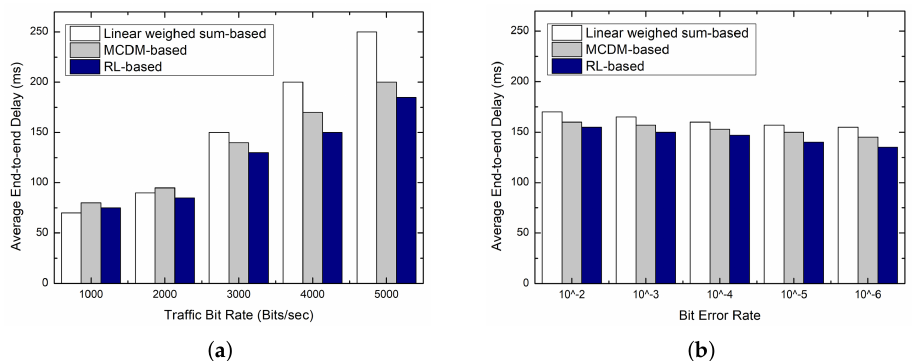
Figure 6. Simulation results: end-to-end delay. ( a ) End-to-end delay according to traffic bit rate; ( b ) End-to-end delay according to bit error